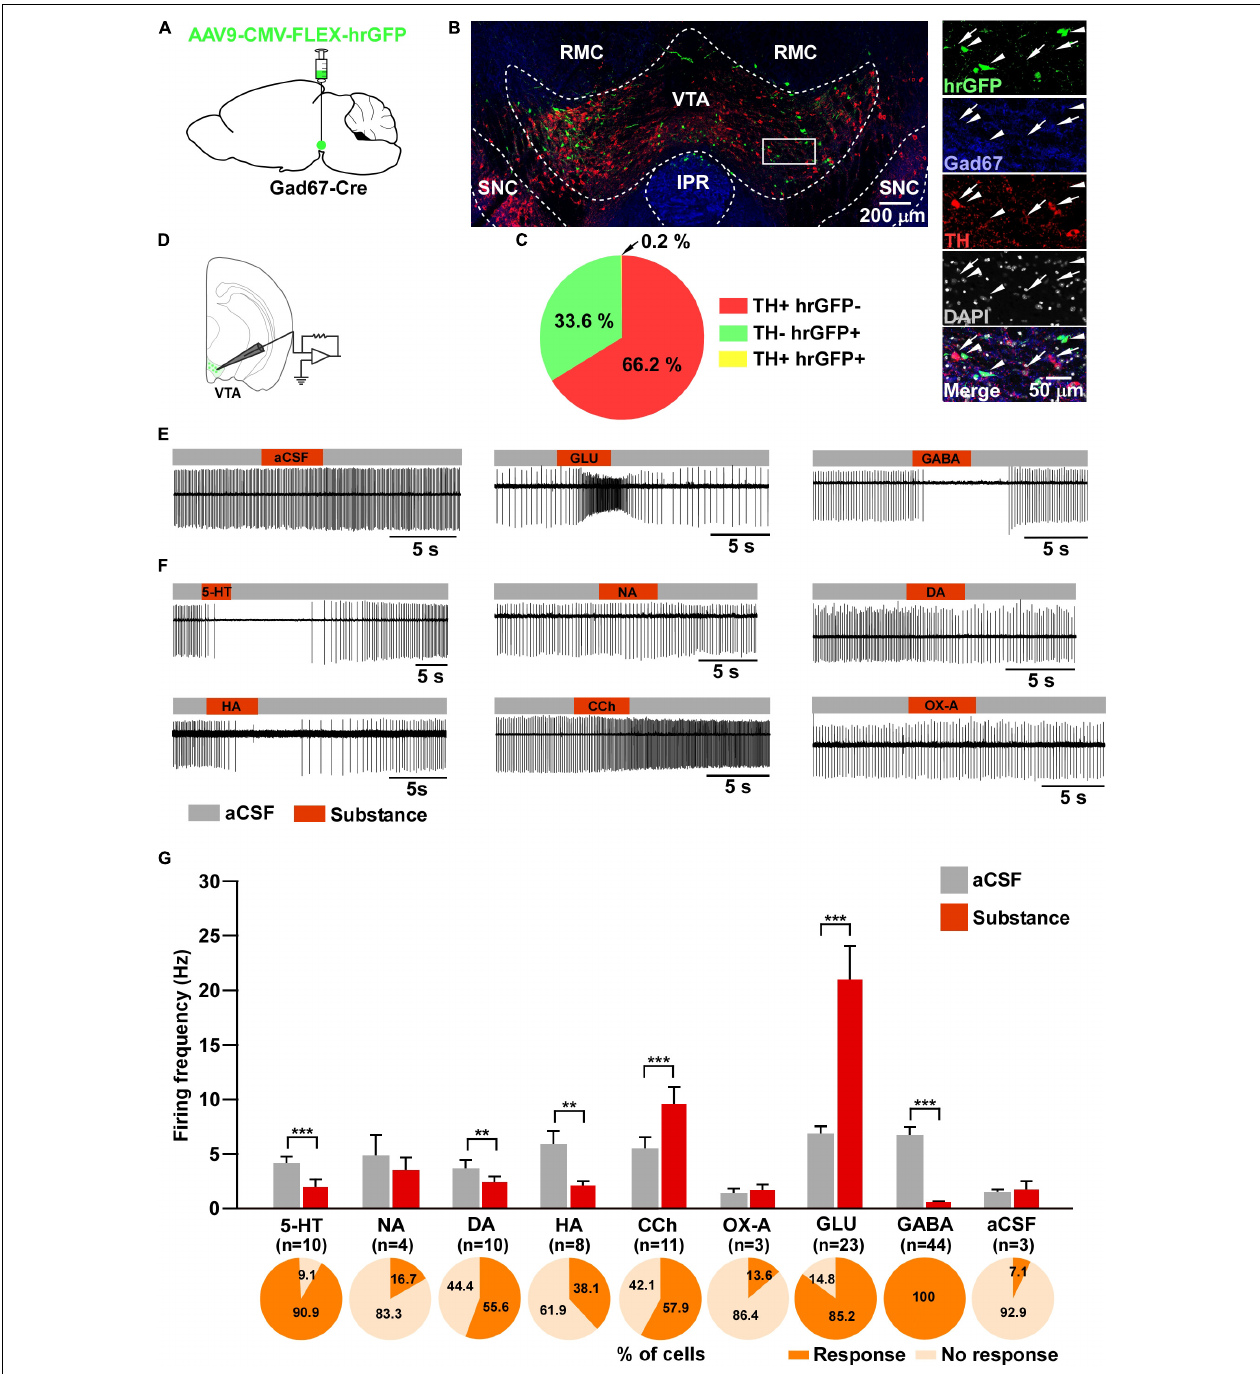
FIGURE 1 | Responsiveness of VTA Gad67 + neurons to neurotransmitters. (A) Schematic of the AAV injection used to visualize VTA Gad67 + neurons. (B) Immunostaining shows expression of hrGFP in the VTA. The white rectangular area is magnified on the right side, demonstrating that hrGFP expression is found only in Gad67-positive neurons (white arrowheads) and not in the DA neurons (white arrows). Green (hrGFP), blue (Gad67), red (TH), gray (DAPI), white (merge). RMC, red nucleus magnocellular; IPR, interpeduncular nucleus; rostral; SNC, substantia nigra compacta. (C) Pie chart showing the percentage of hrGFP-expressing cells among DA and non-DA neurons in the VTA ( n = 4 mice). (D) Schematic of the patch clamp recording from VTA Gad67 + neurons. (E,F) Representative traces showing the effect of local application. Gray bars indicate aCSF application and red bars indicate substance application. (G) Bar graphs summarize the firing frequency of responsive cells following the application of each substance, and pie charts show the percentage of responsive and non-responsive cells, where n indicates the number of responsive cells. Data are shown as means ± SEMs. Statistical analyses were made using two-tailed paired Student’s t -test. ** p < 0.01, *** p < 0.001.